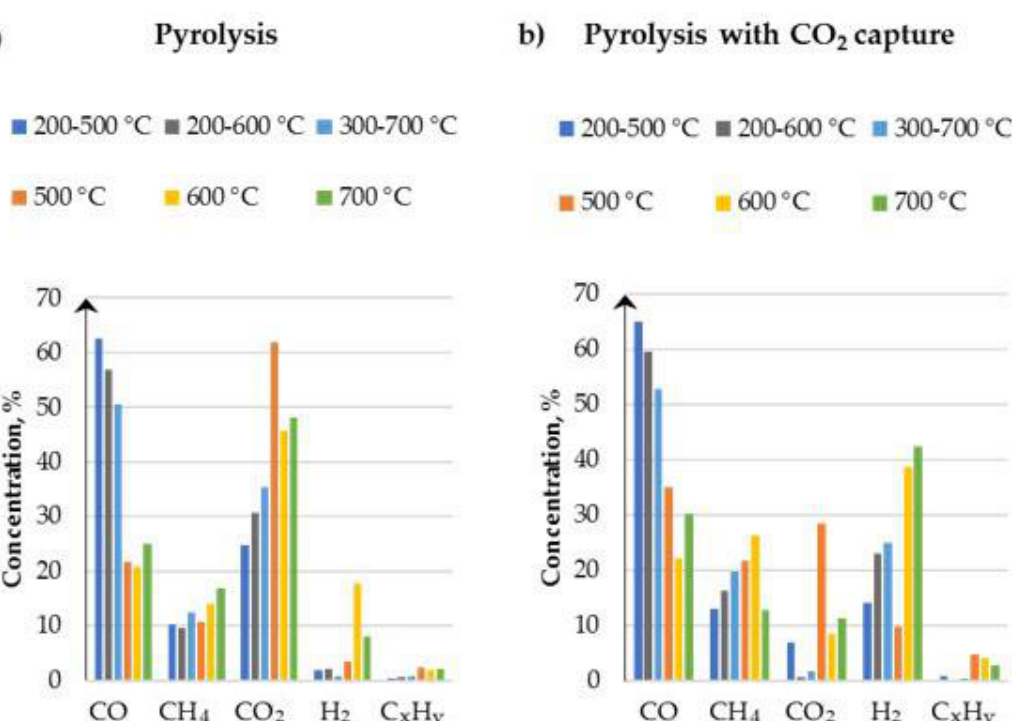
Figure 13. Syngas composition from the pyrolysis process: ( a ) without CO 2 capture and ( b ) with CO 2